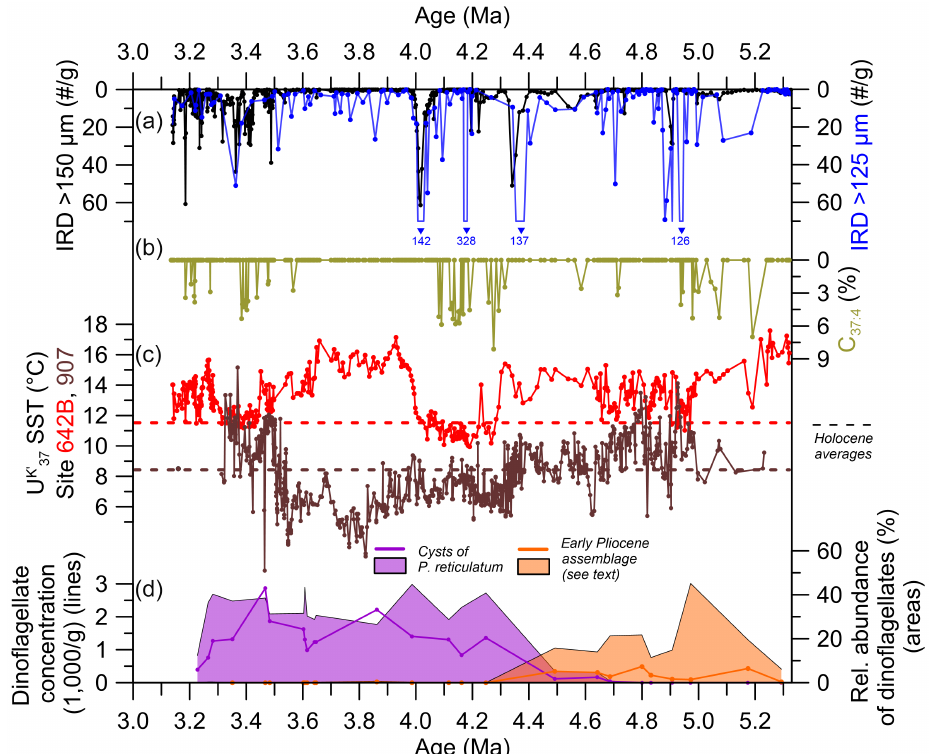
(cid:48) SSTs (Müller et 37